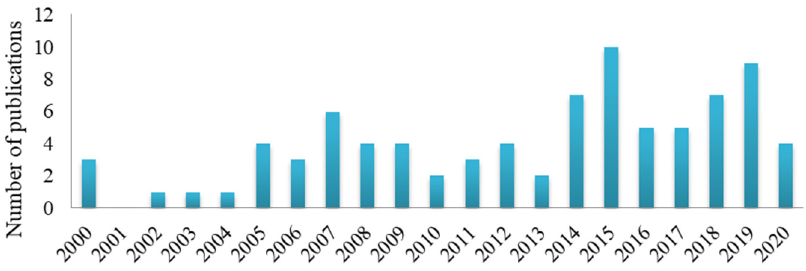
Figure 2. Publications on the topic over 2001–2021.